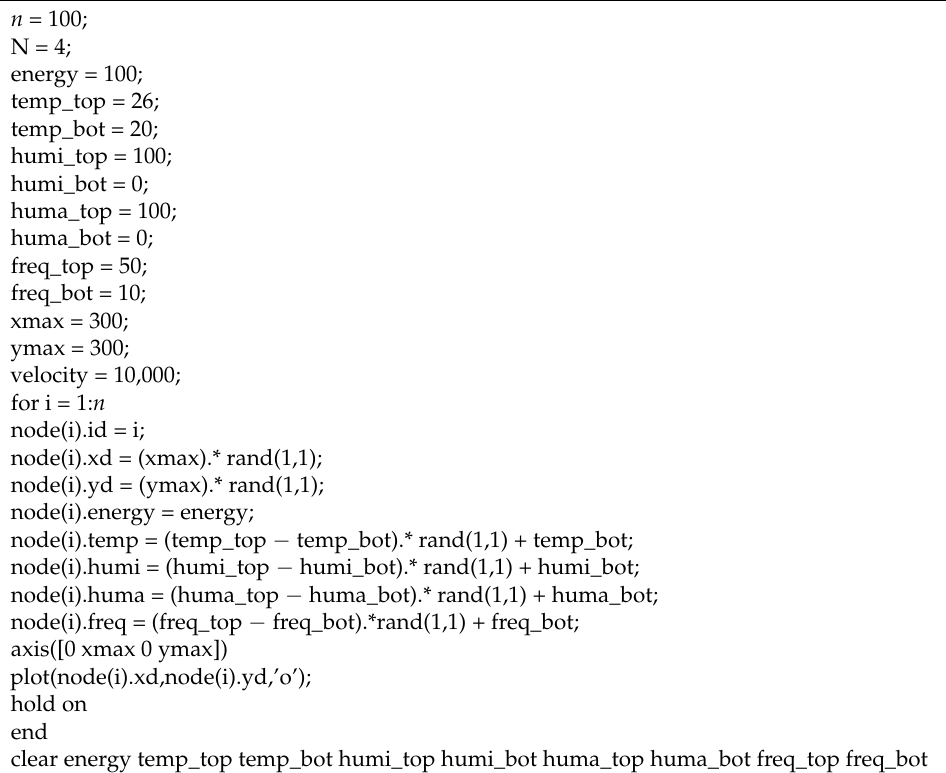
Table 2. Algorithm 1. Algorithm 1: Temperature and Humidity Criteria